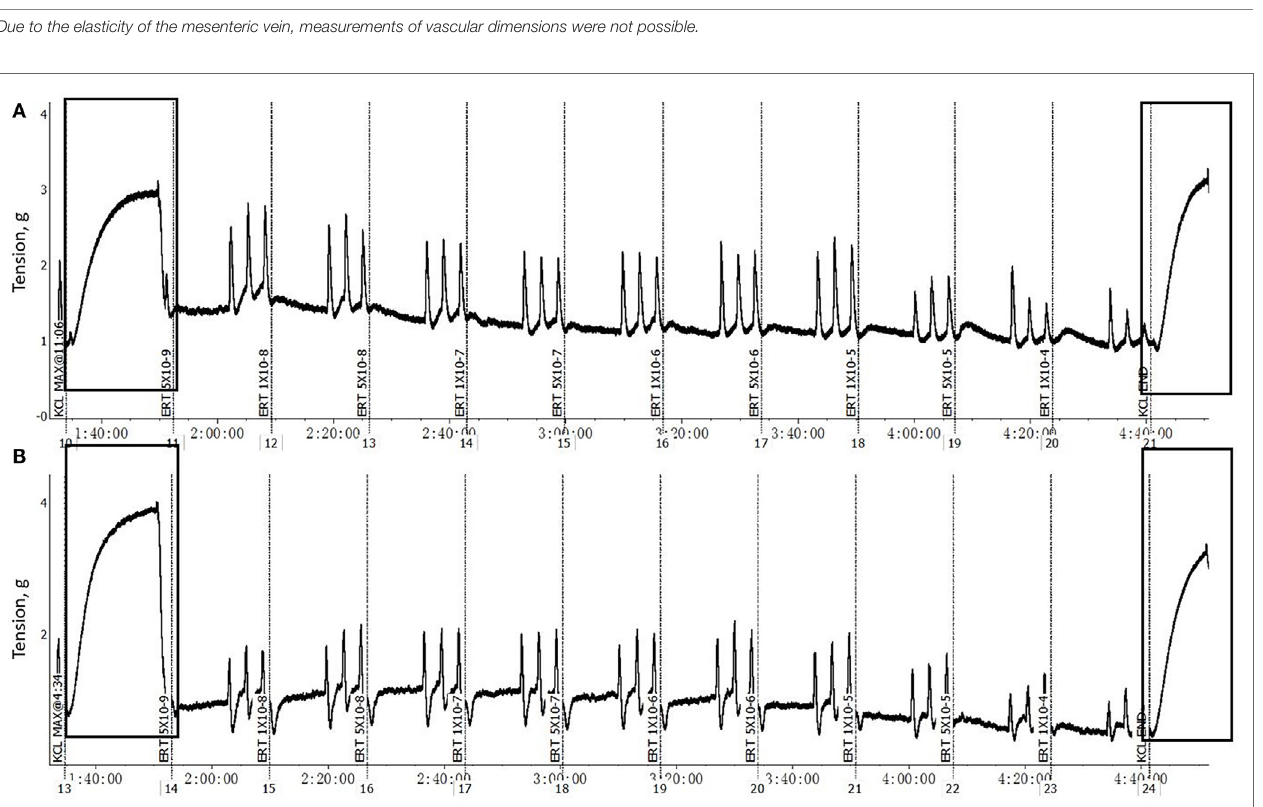
FigUre 1 | example of a typical response of mesenteric artery (a) and vein ( B ) cross-sections, after pretreated with 1 × 10 − 6 M eXT and 1 × 10 − 6 M F and 1 × 10 − 6 M B (eXT + F + B ), to increasing concentrations of erT (5 × 10 − 9 to 1 × 10 − 4 M) . The rectangles highlighted regions are the initial and end KCl (0.12 M)